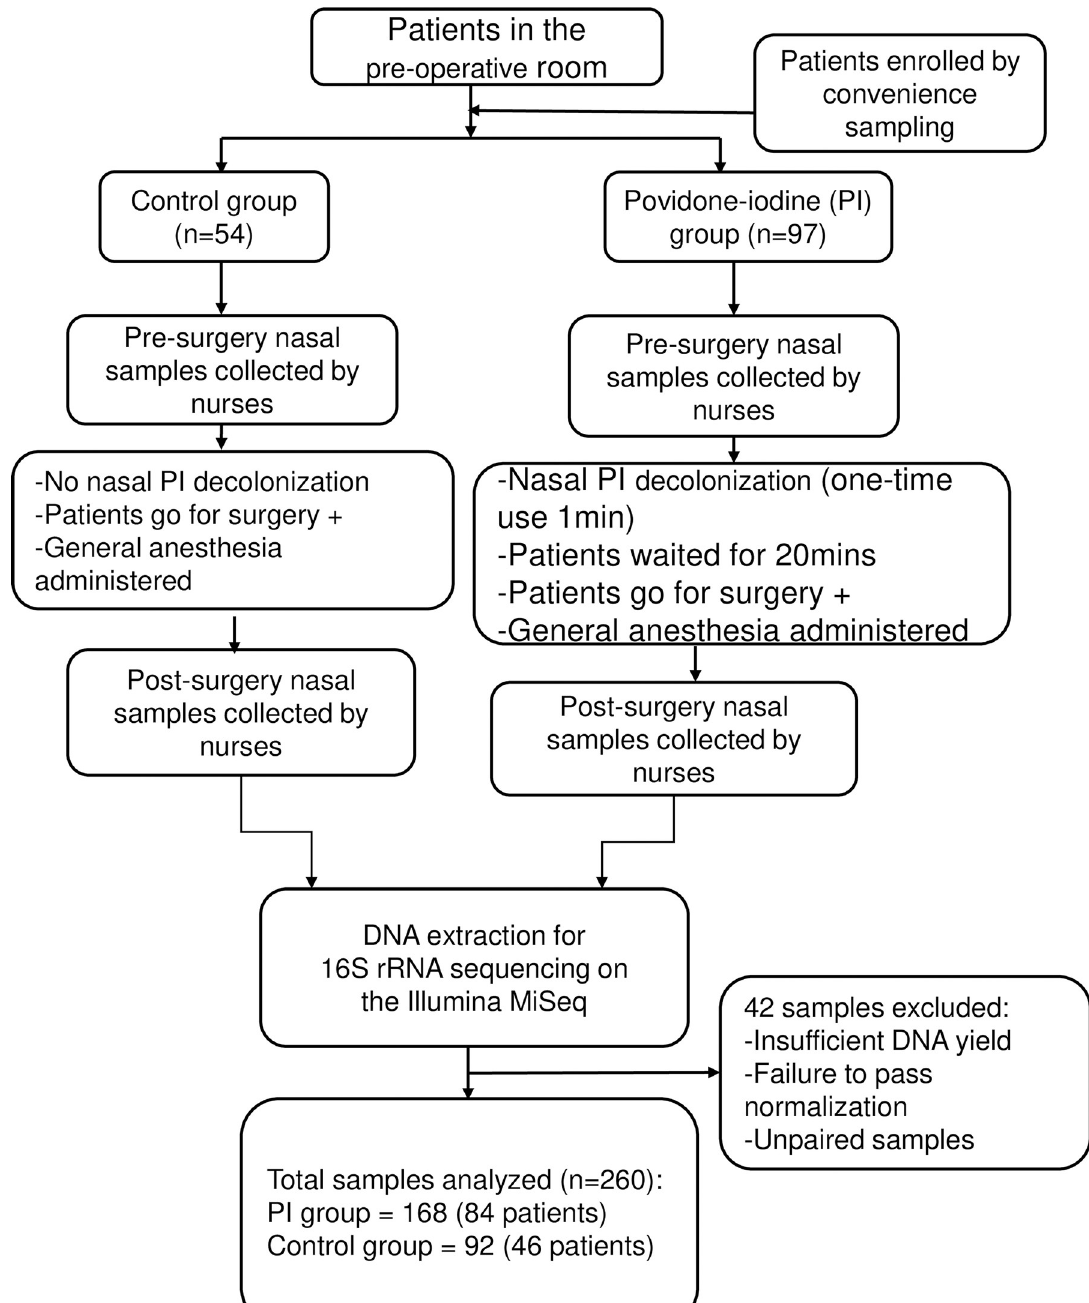
Fig 1. Study design components. A quality improvement study schematic outlining sample collection, nasal povidone-iodine (PI) application, and sequencing method. https://doi.org/10.1371/journal.pone.0278699.g001 average 21.65% (standard error (SE) = 0.06) of the reads in the pre-surgery control samples and 18.79% (SE = 0.06) in the post-surgery control samples, representing a 13.2% decrease. However, this difference was not statistically significant (FDR adjusted P = 0.991). In the con- trol group, OTU2, classified to the genus Corynebacterium , and its abundance increased from